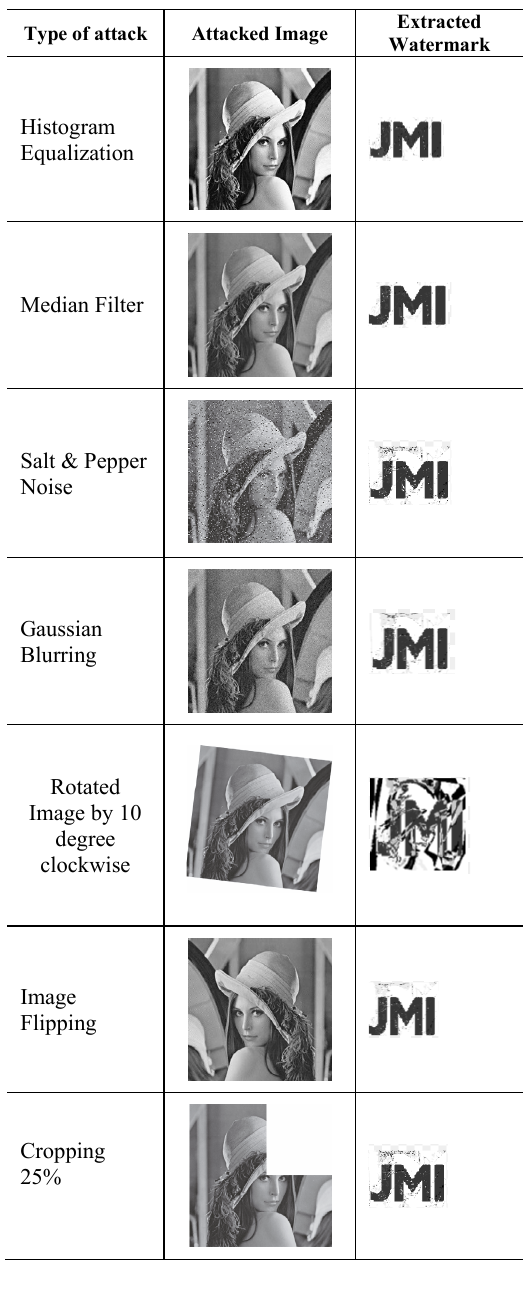
Table 1. Attacked images and extracted robust JMI watermarks after various attacks